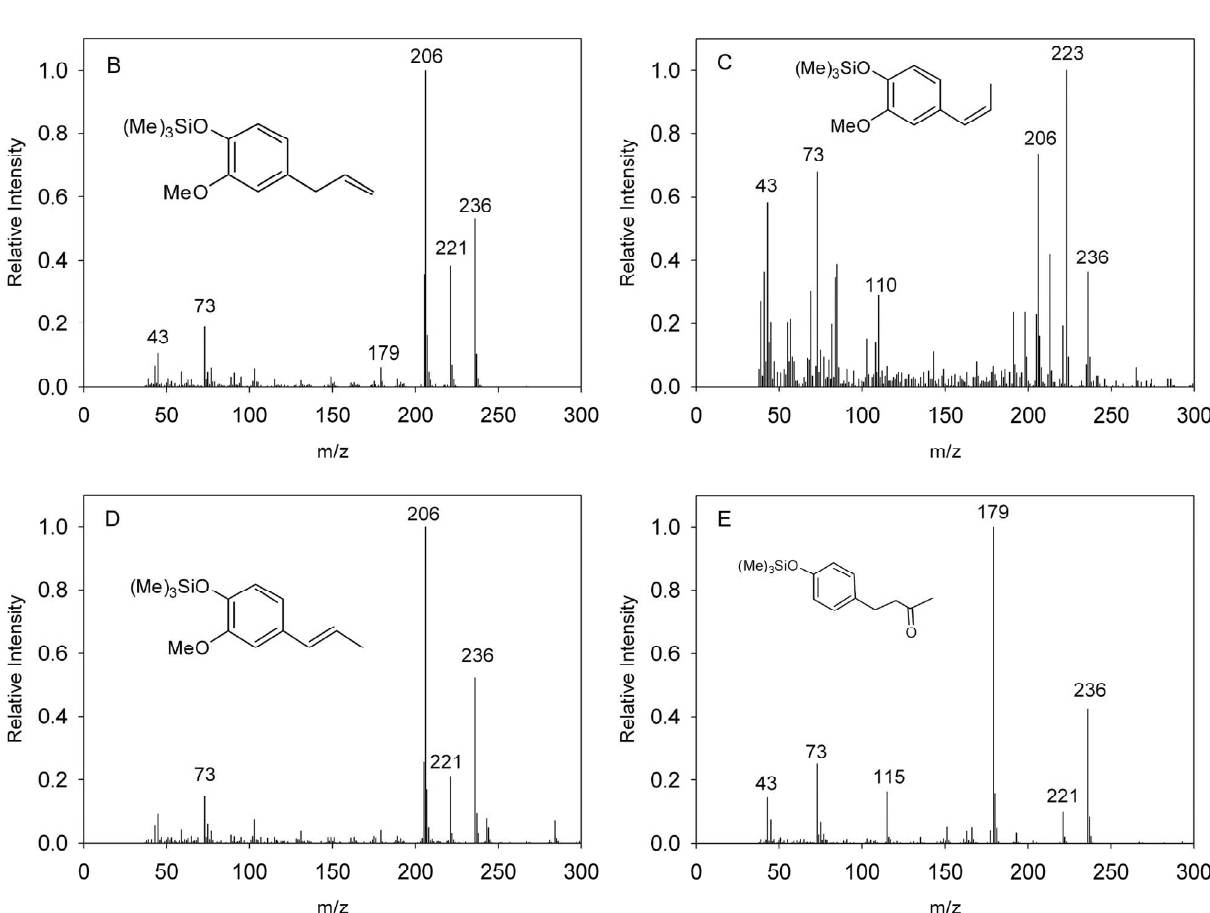
F IGURE 4. Mass spectra of selected peaks from gas chromatograms of derivatized samples; letters refer to peaks labeled in in Fig. 3.